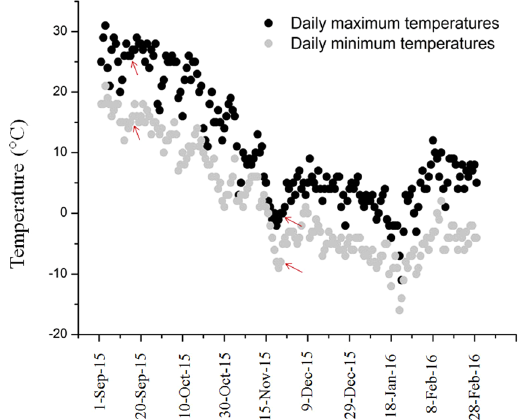
Figure 1. Daily maximum and minimum temperatures for Beijing city during September, 2015 to February, 2016. Red arrow Iindicates insect samples collection dates.